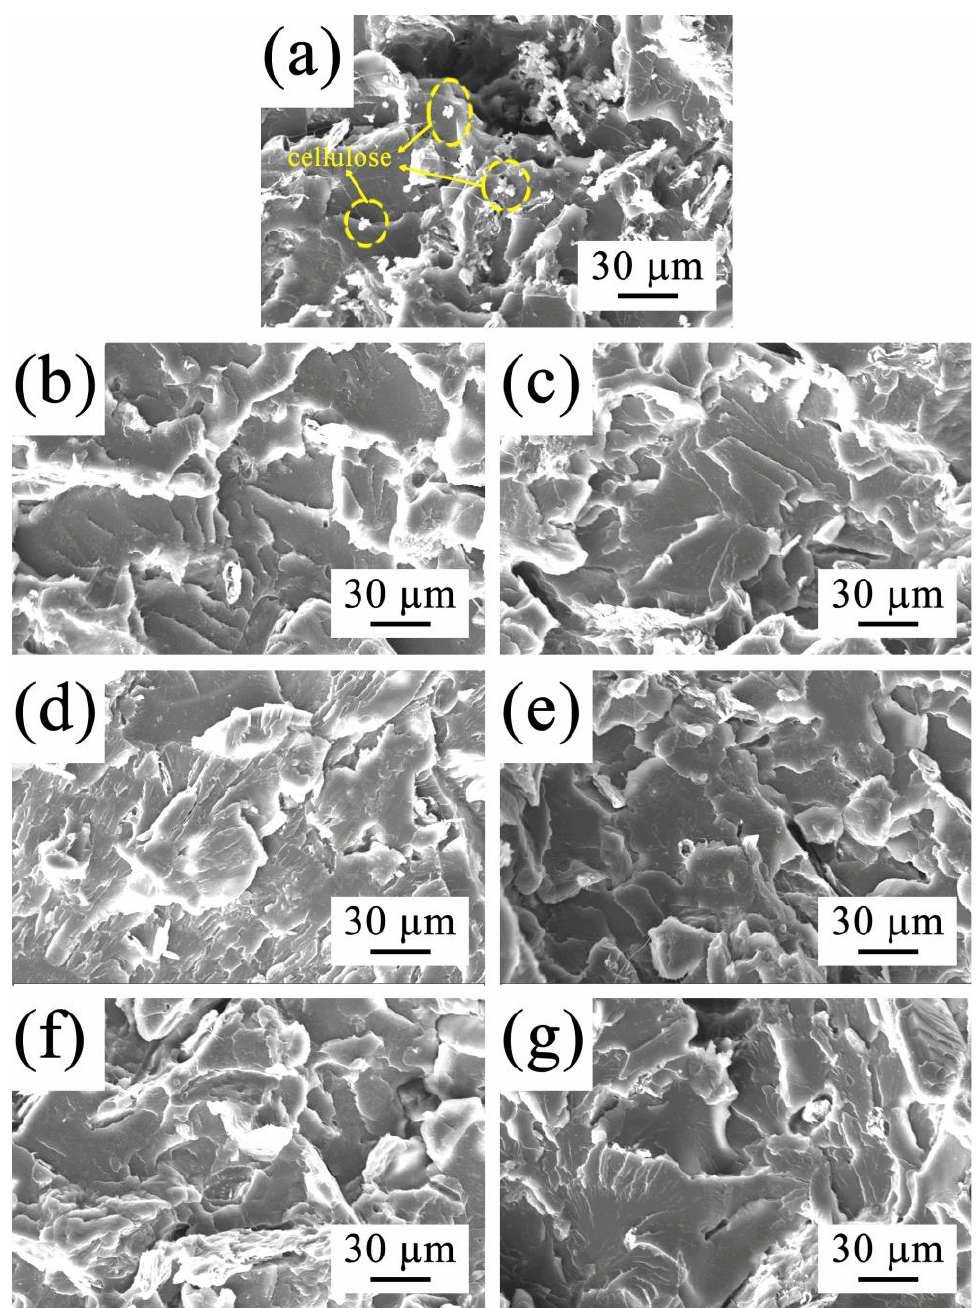
Figure 3. SEM images of cross-section after tensile testing: ( a ) C/P blend, ( b ) C/P/12-1, ( c ) C/P/12-3,